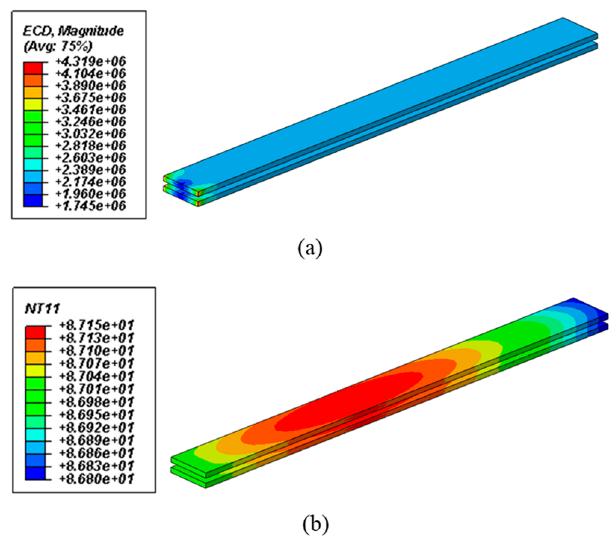
Figure 3. Results of the electromagnetic and thermal analysis for plate-type bus-bar: ( a ) Current density; ( b ) thermal gradient.